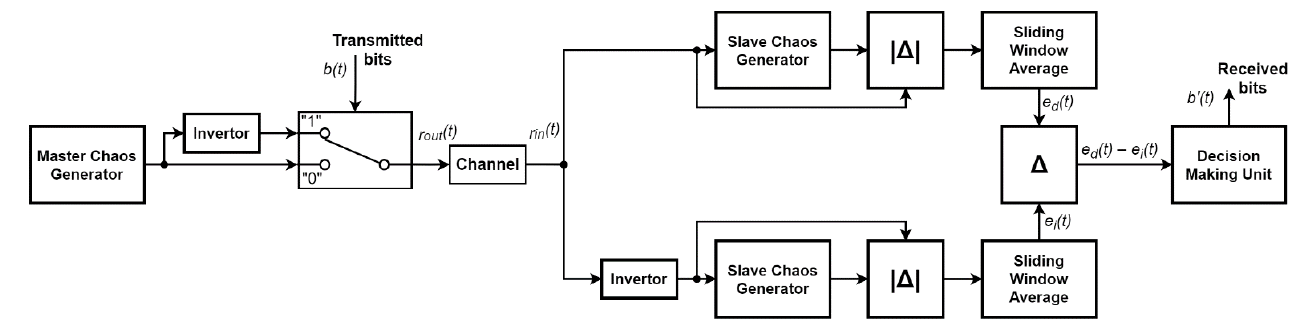
Figure 5. Structure of ACSK modulation with baseband channel.